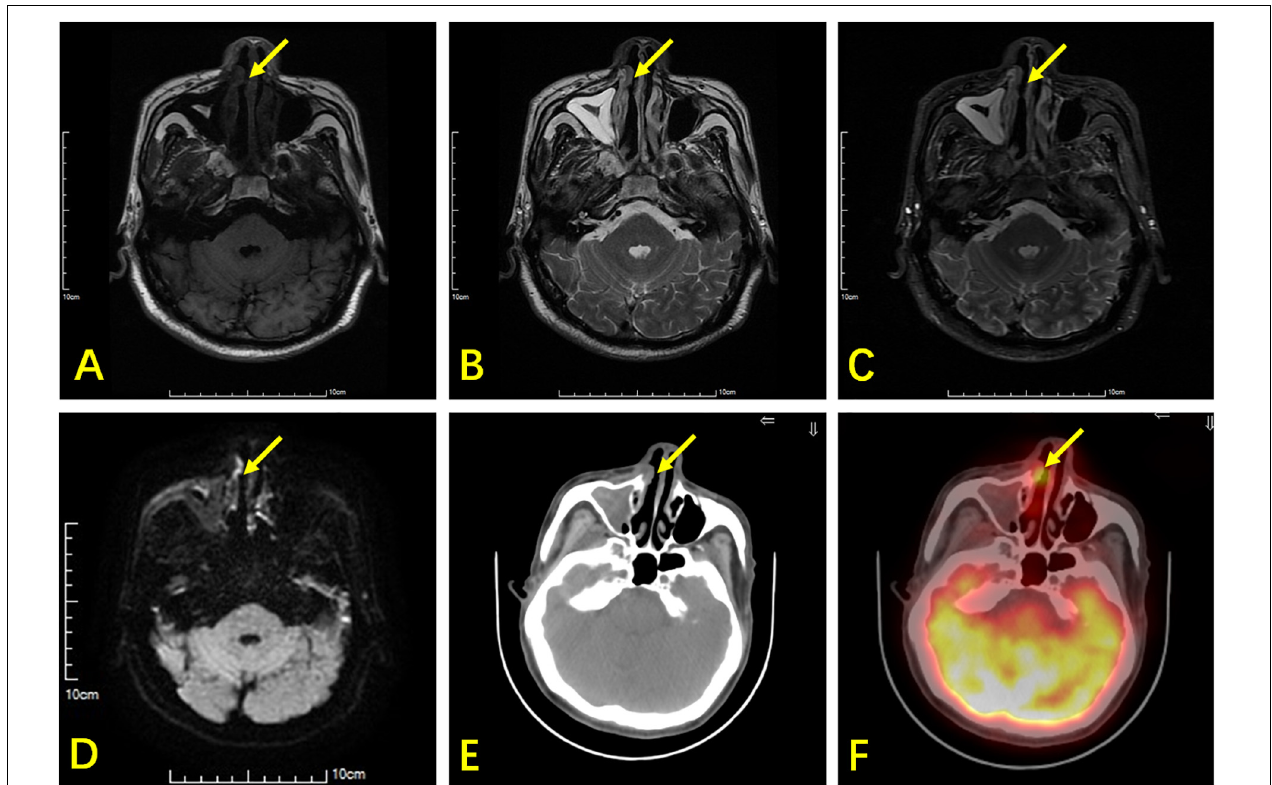
FIGURE 2 | A 66-year-old man with ENKTL. T1WI (A) and T2WI (B) show bilateral thickening in the nasal mucosa with isointensity. (C) Contrast-enhanced T1WI show bilateral heterogeneous enhancement in the nasal mucosa. (D) DWI shows limited lesion diffusion of bilateral nasal mucosa. (E) Axial CT shows a small soft tissue mass (arrow) in the right nasal cavity. (F) 18 F-FDG PET/CT shows high glucose metabolism in the small soft tissue mass, which was an ENKTL lesion, but this was non-specific in MR.